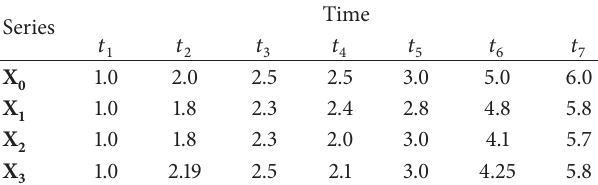
Table 1: Original time series from [2].